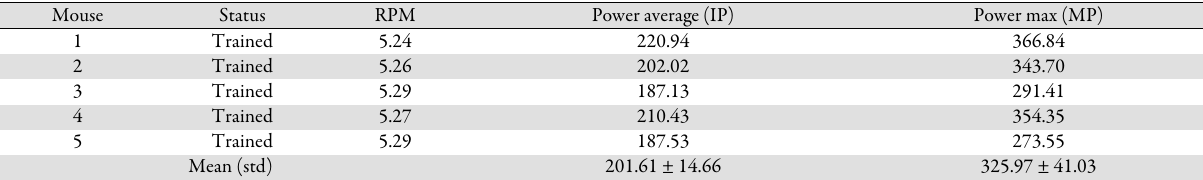
Table 3. Data for the trained group at effort activity for 20 minutes Mouse